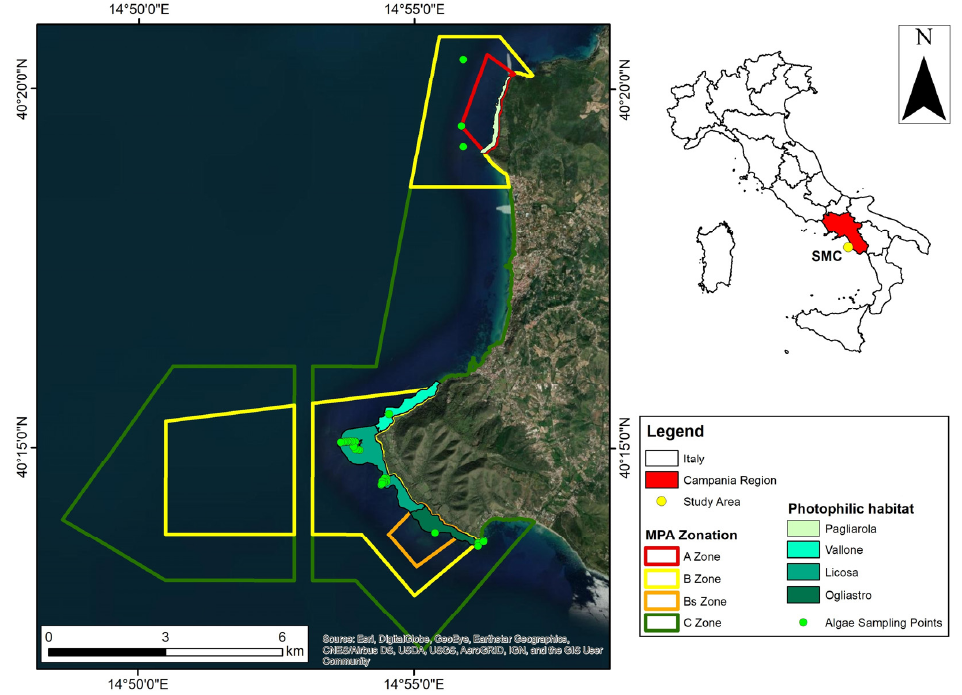
Figure 1. Study area in the MPA Santa Maria di Castellabate (SMC; Tyrrhenian Sea, Italy). Photophilic habitat refers to [57]. Green dots represent the algal collection sites for taxonomic identification.